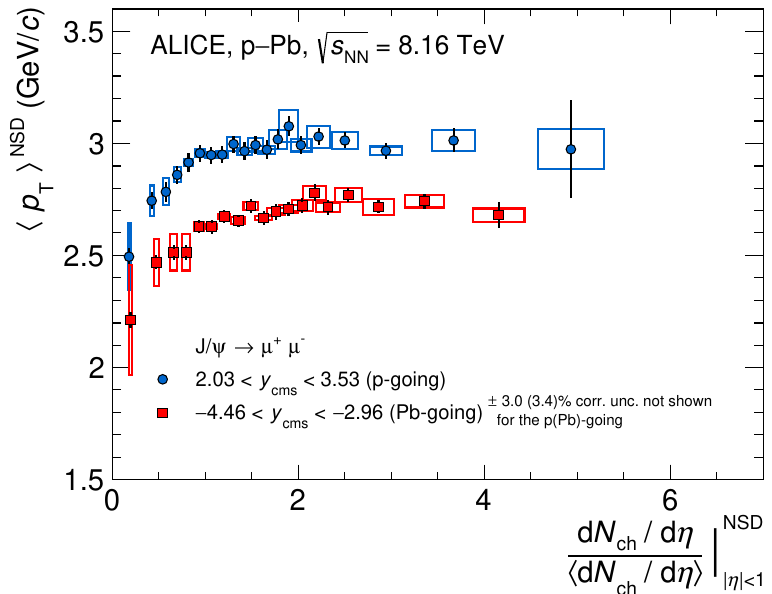
Figure 4 . Average transverse momentum of inclusive J = at forward and backward rapidities as a function of the normalized charged-particle pseudorapidity density, measured at midrapidity, in p p-Pb collisions at s NN = 8 : 16 TeV. The vertical bars represent the statistical uncertainties, the boxes the systematic